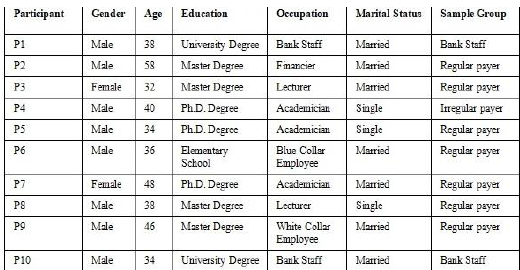
Table 1. Demographics of Participants